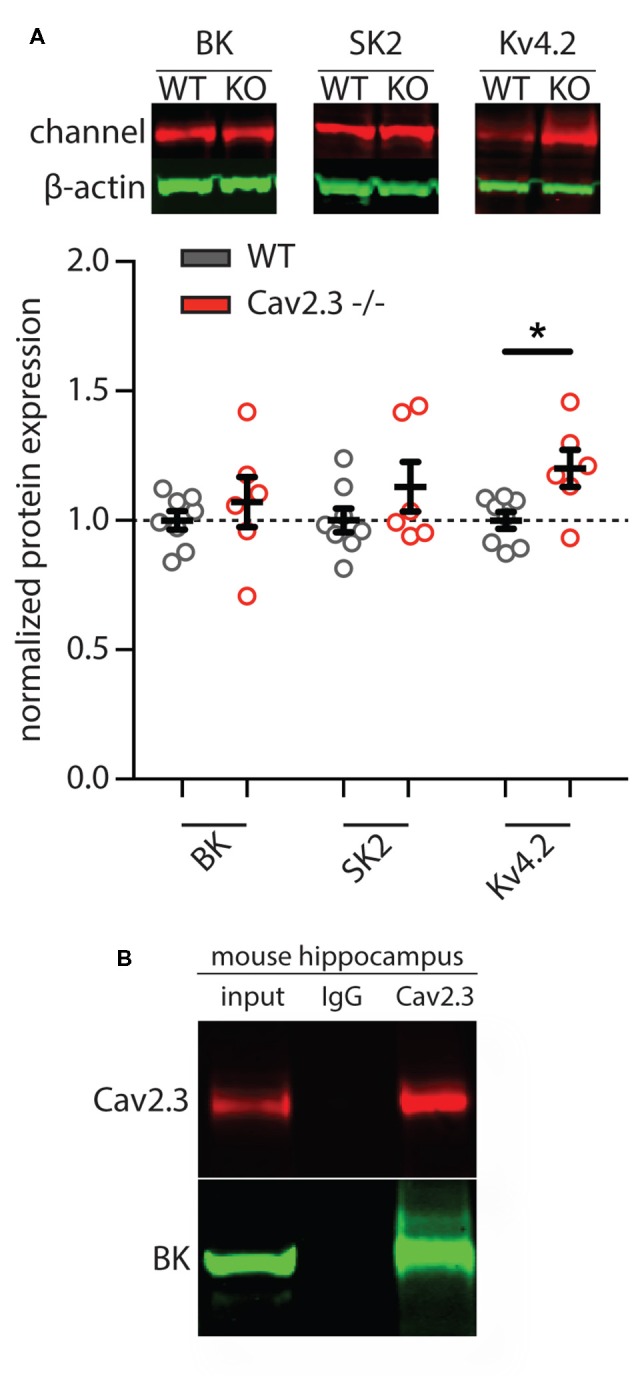
Representative images and quantification of western blot analysis of calcium- and voltage-gated potassium channels. (A) Total expression of BK and SK2 potassium channels in mouse hippocampus showed no significant differences between WT and Cav2.3-KO mice (WT = 8, KO = 6; p > 0.05). In contrast, in the Cav2.3-KO, the total level of Kv4.2 was significantly increased compared to the WT (WT = 8, KO = 6; p < 0.05). Pooled data were normalized to total beta-actin level. Error bars represent SEM. (B) Native co-IP from mouse hippocampus shows that endogenous Cav2.3 interacts with BK-channel. IgG as nonspecific control (*p < 0.05).